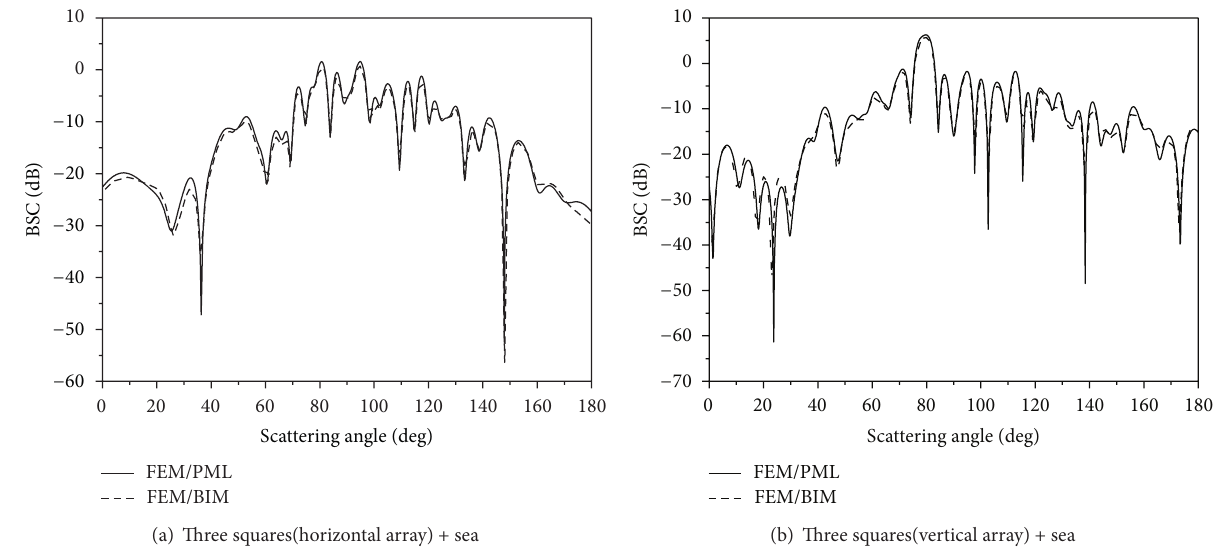
Figure 4: BSC from three squares above the PM rough sea surface.